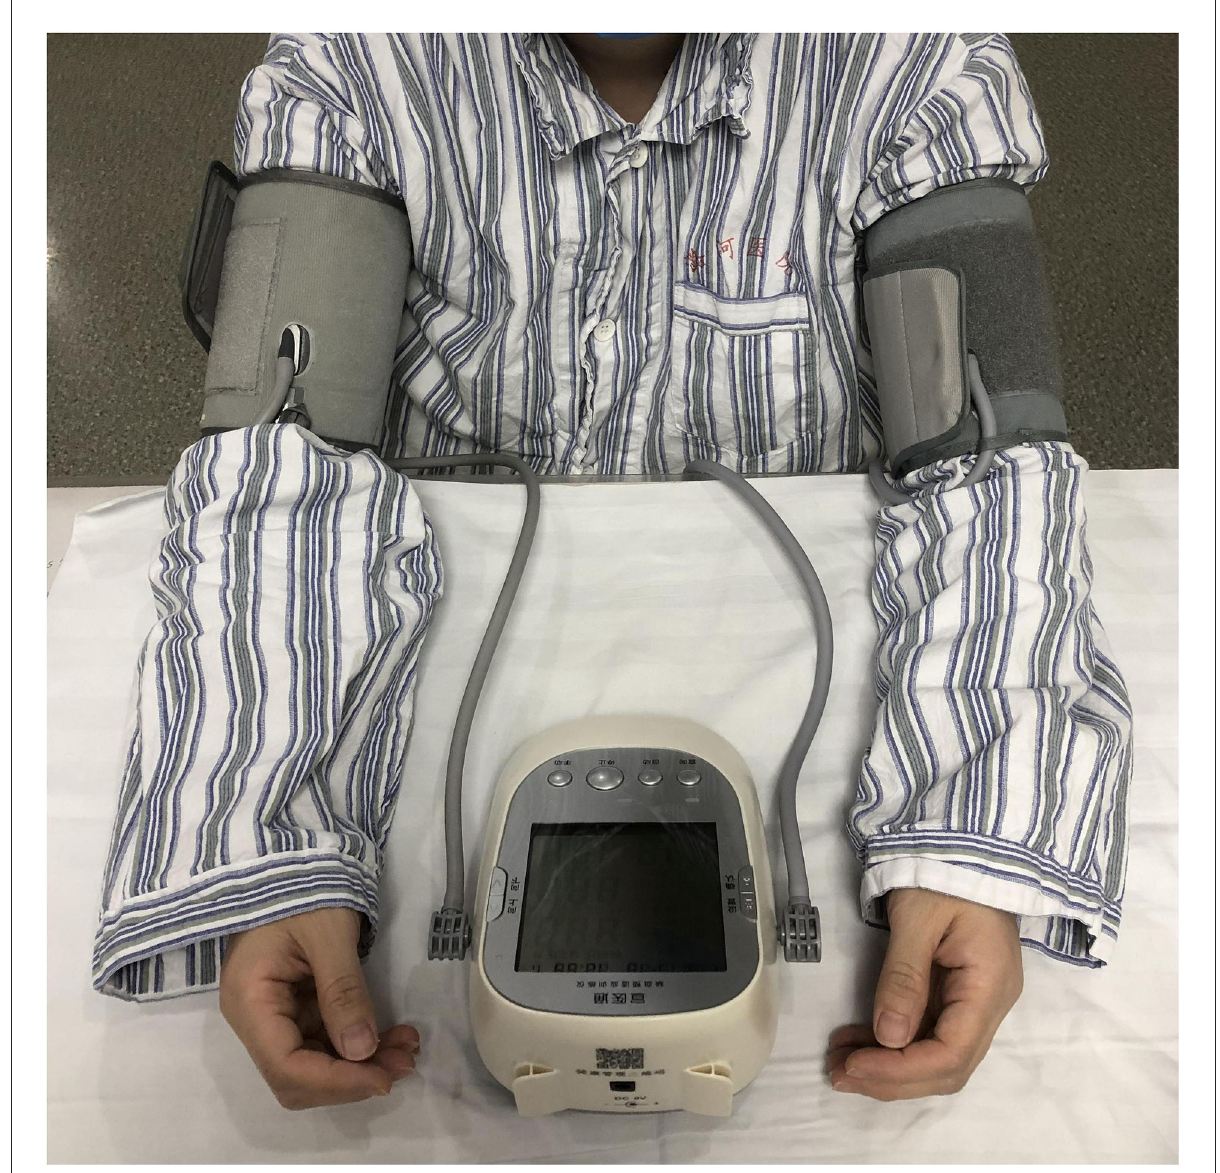
FIGURE1 Remote ischemic conditioning (RIC) with an electronic tourniquet cuff